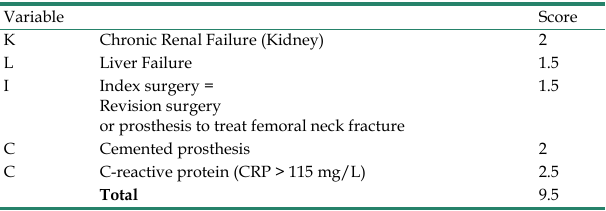
Table 1: KLIC-score, as described by Tornero et al.